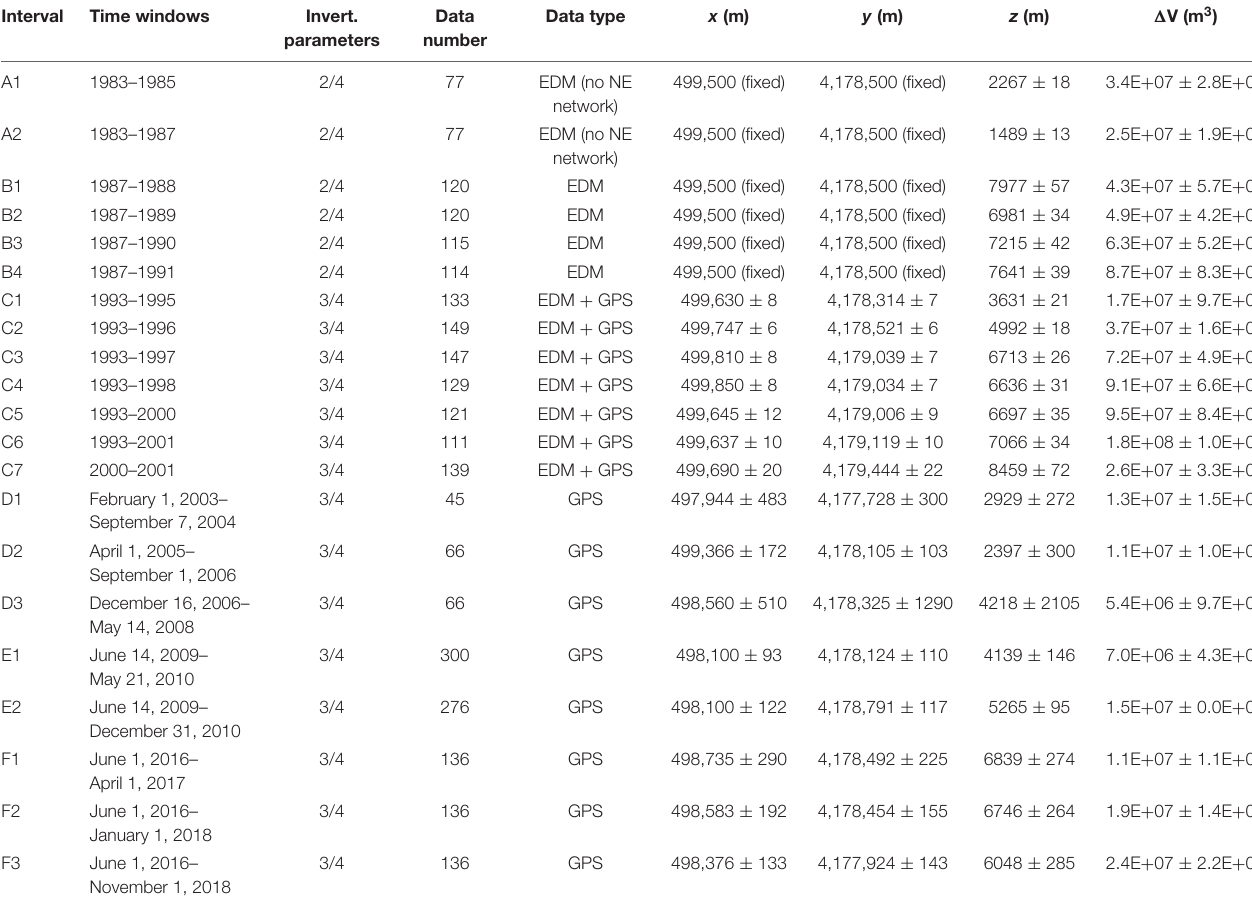
TABLE 3 | Number and type of observables, inverted source parameters, and associated errors for the pressure sources estimated in this study. Interval Time windows Invert.